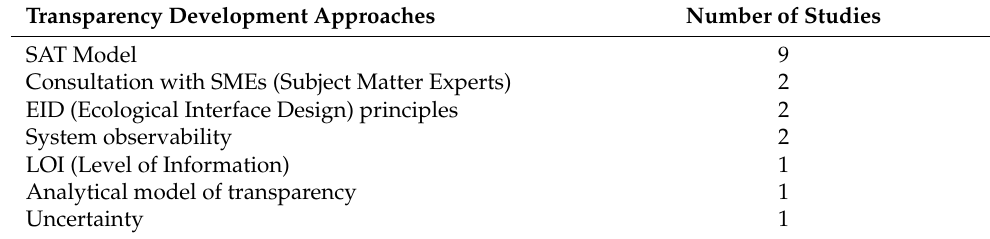
Table 4. Transparency schemes. Transparency Development